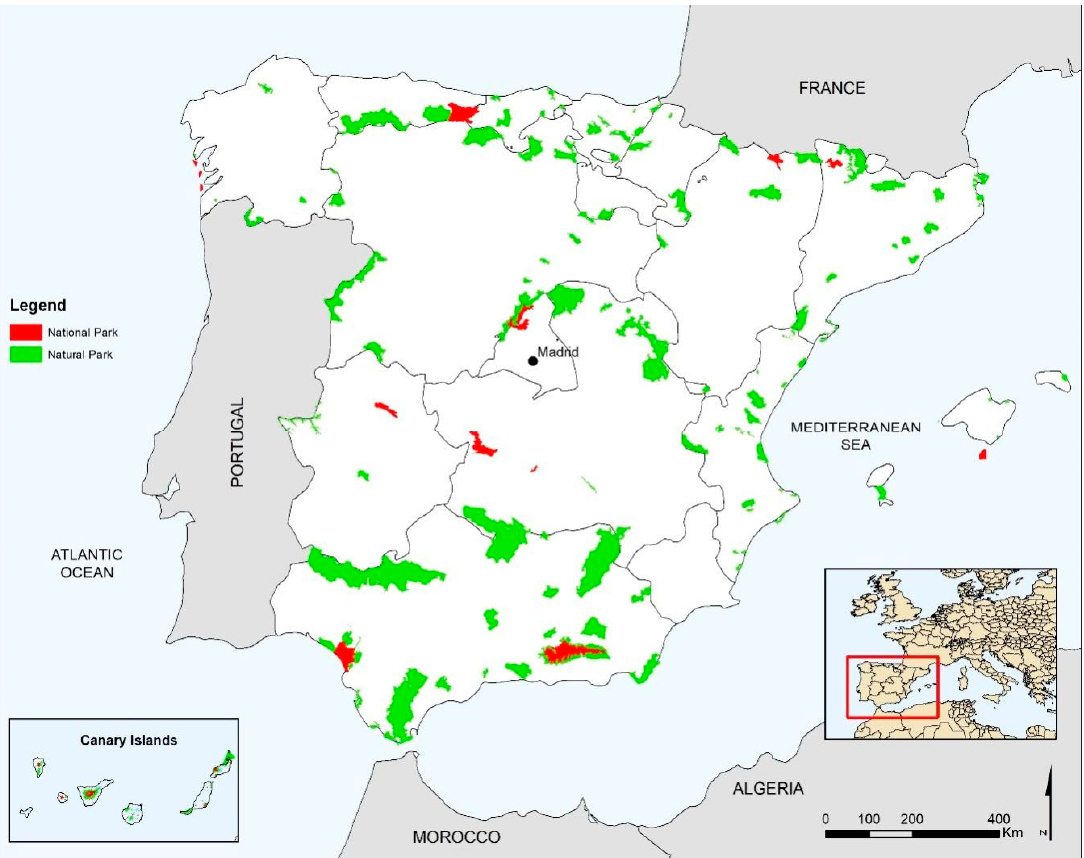
Figure 1. Natural and National Parks of Spain. Source: Prepared by the authors on the basis of data from the Ministry of Agriculture and Fisheries, Food and Environment (Government of Spain).